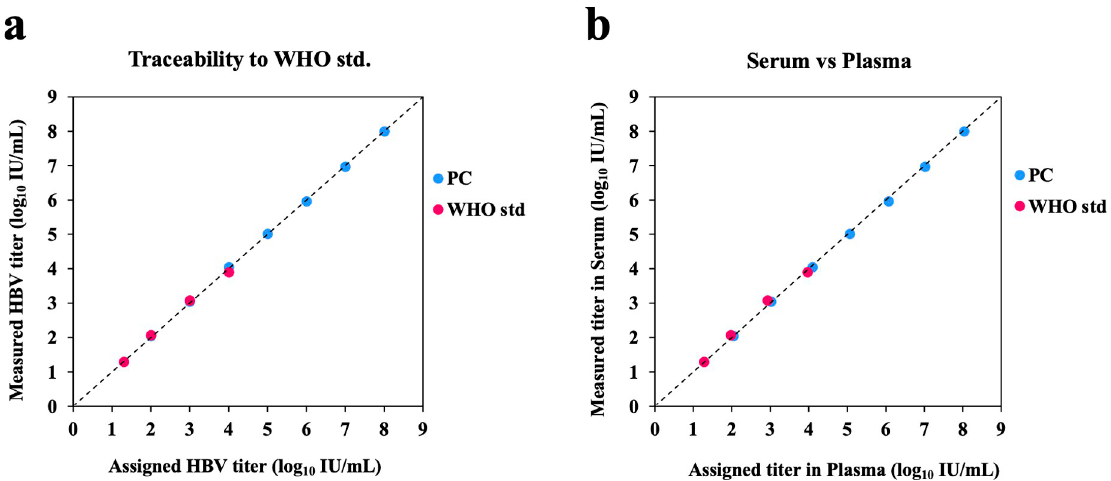
Fig 3. Traceability to the WHO international standard and matrix equivalency between serum and plasma on μ TASWako g1 analyzer. Dilutions of the positive control (PC) and WHO international standard (WHO std) were tested in three replicates for each concentration. The dots represent the mean log 10 transformed titer. The dashed line represents the equality line.